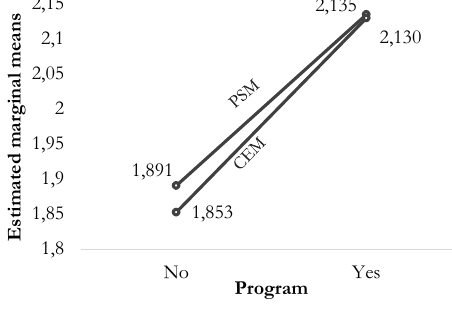
Fig. 1 – Estimated marginal means of After_EI for PSM and CEM samples (Source: own